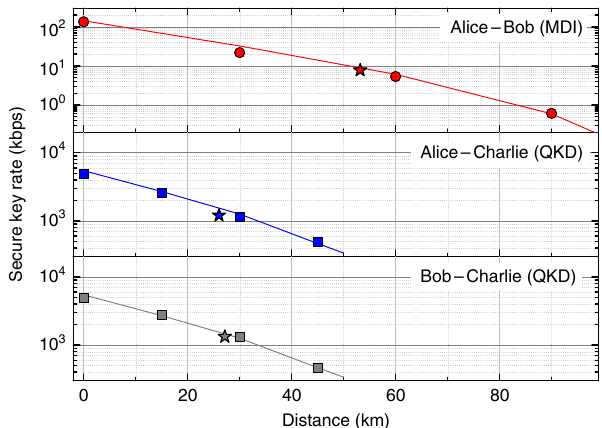
Fig. 3 Secure key rates vs. distance. MDI-QKD (top diagram) and QKD (centre and bottom diagrams) secure key rates for a Z ( X ) basis probability equal to 80% (20%) and a security parameter ϵ sec ≲ 10 − 10 are shown as a function of distance. Because the recon fi gurable scheme is symmetrically deployed, the distance between Alice and Bob (top) is approximately twice the distance between Alice and Charlie (centre) and Bob and Charlie (bottom). All the distances have been calculated assuming 0.2 dB/km attenuation on the channel, except for the data points indicated by stars, where a real fi bre was used. The projected time to attain the shown key rates is 25 h of which 3 min are spent on QKD and the rest on MDI-QKD, to balance their key rates. The fi tting lines are the result of a numerical simulation with the parameters mentioned above and the following additional ones: Charlie ’ s insertion loss, 1.1 dB; detectors ’ ef fi ciency and temperature, 20% and 0°, respectively; afterpulsing, 4%; dark count probability per gate, 1.6 × 10 − 5 ; error correction coef fi cient, 1.16